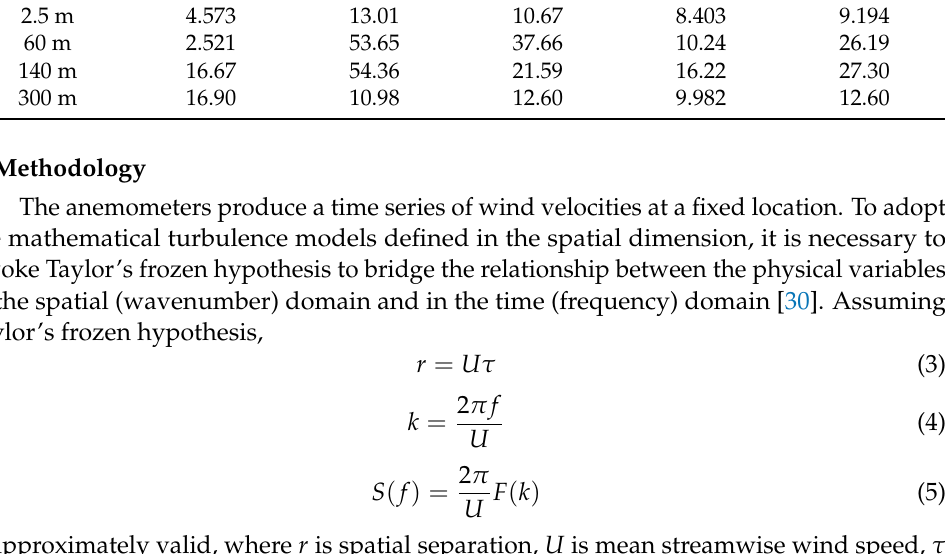
Figure 3. The available and the missing portion of produced EDR at the four levels. Green color indicates that EDR was produced and regarded as reliable, while red color indicates that EDR was not produced and regarded as missing at the given time. Table 1. The portion of the missing values of EDR in the winter, spring, summer, fall, and for the total one-year period. The unit is %.